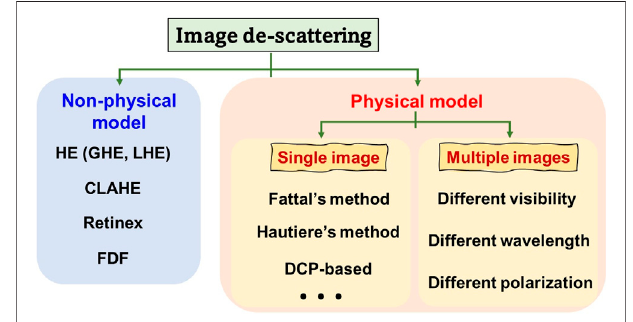
FIGURE 1 | Classi fi cation of dehazing/de-scattering